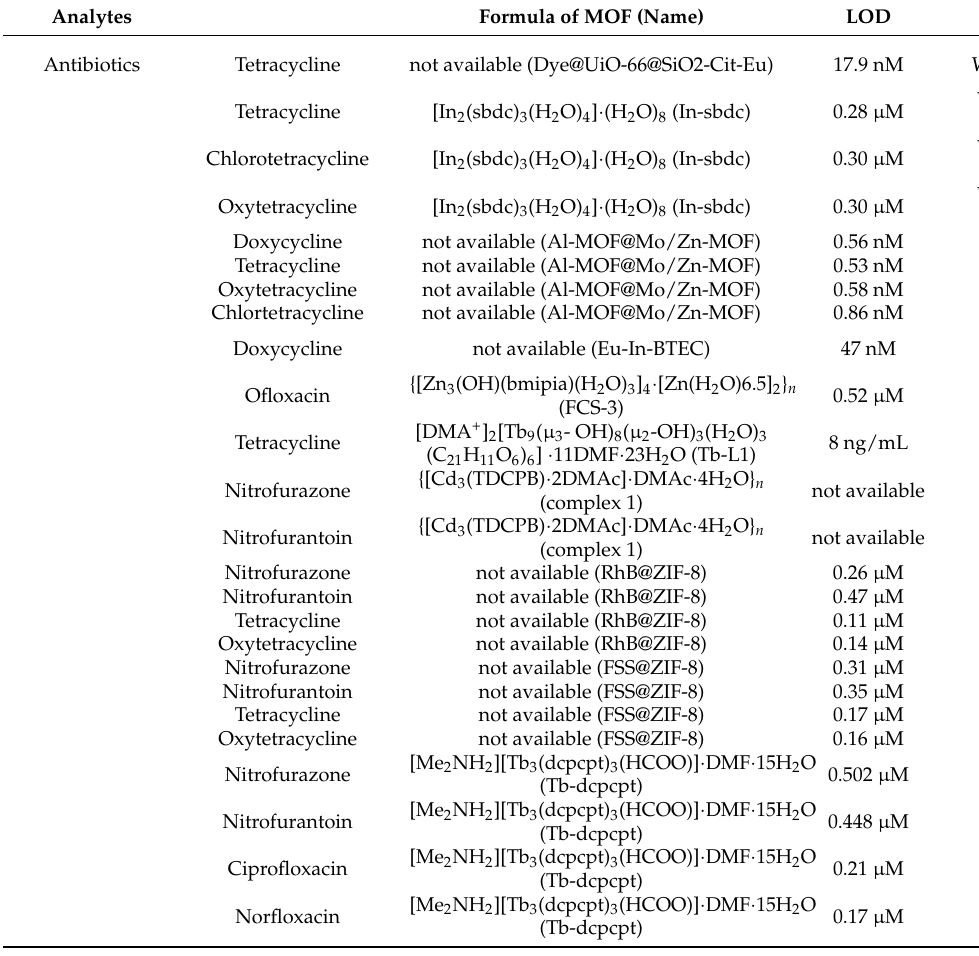
Table 1. A summary of representative examples of NMOFs for food